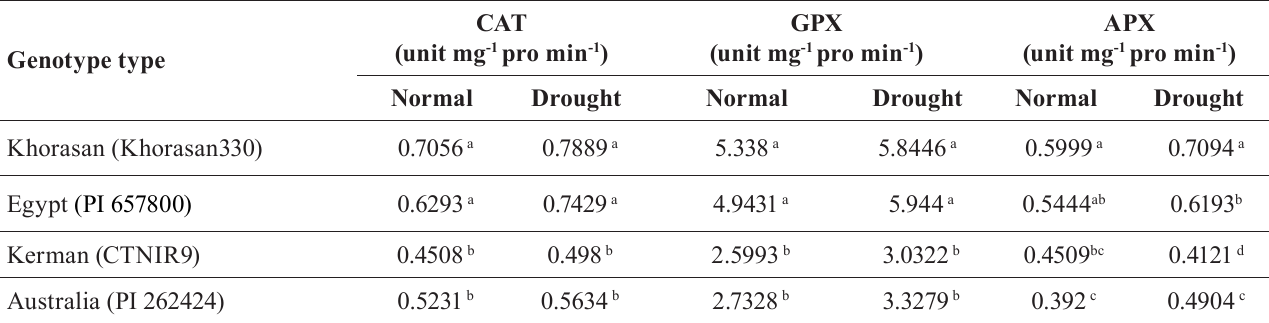
TABLE III - Mean comparison for antioxidant activities of radish seedlings affected by allelopathic potential of safflower root residue grown under normal irrigation and drought stress